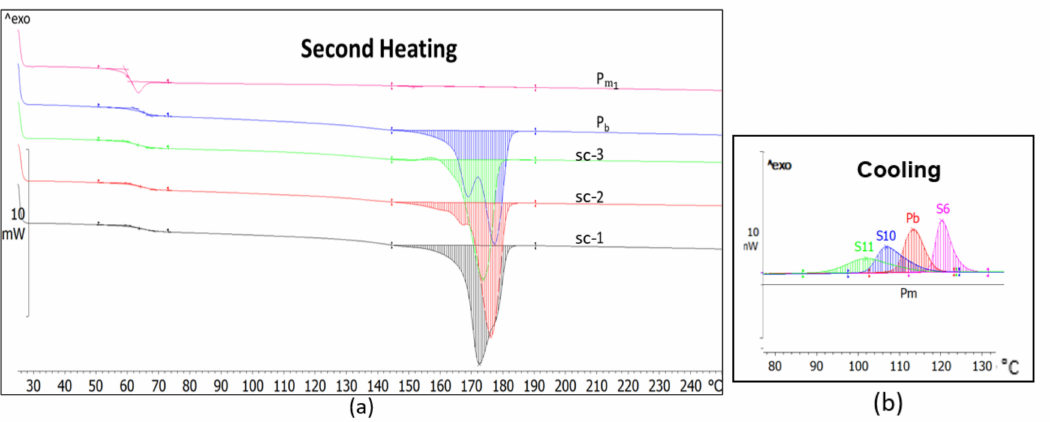
Figure 6. DSC thermograms of the sc-1, sc-2 and sc-3 compounds and of the blended PLA grades (P b , Pm 1 ) after the second heating (10 ◦ C/min) ( a ) and cooling (2 ◦ C/min) ( b